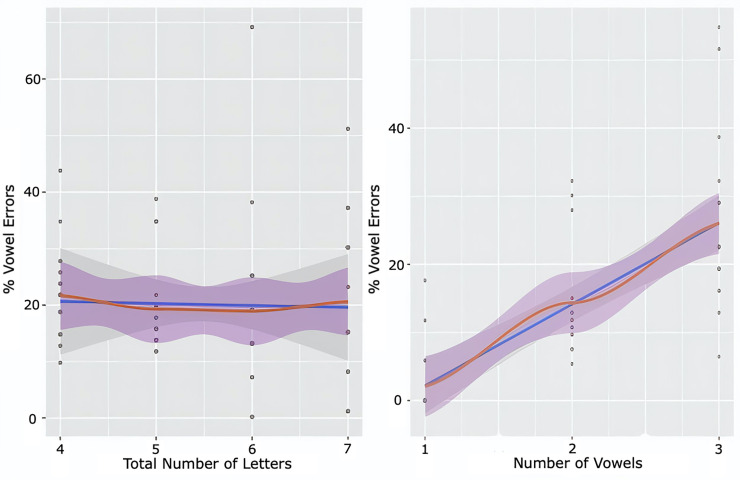
The regression lines (blue) and LOWESS smoothing curve (red) showing the relation between vowel error rate and the number of vowels in the word (left) and between vowel error rate and the total number of letters in the word (right).